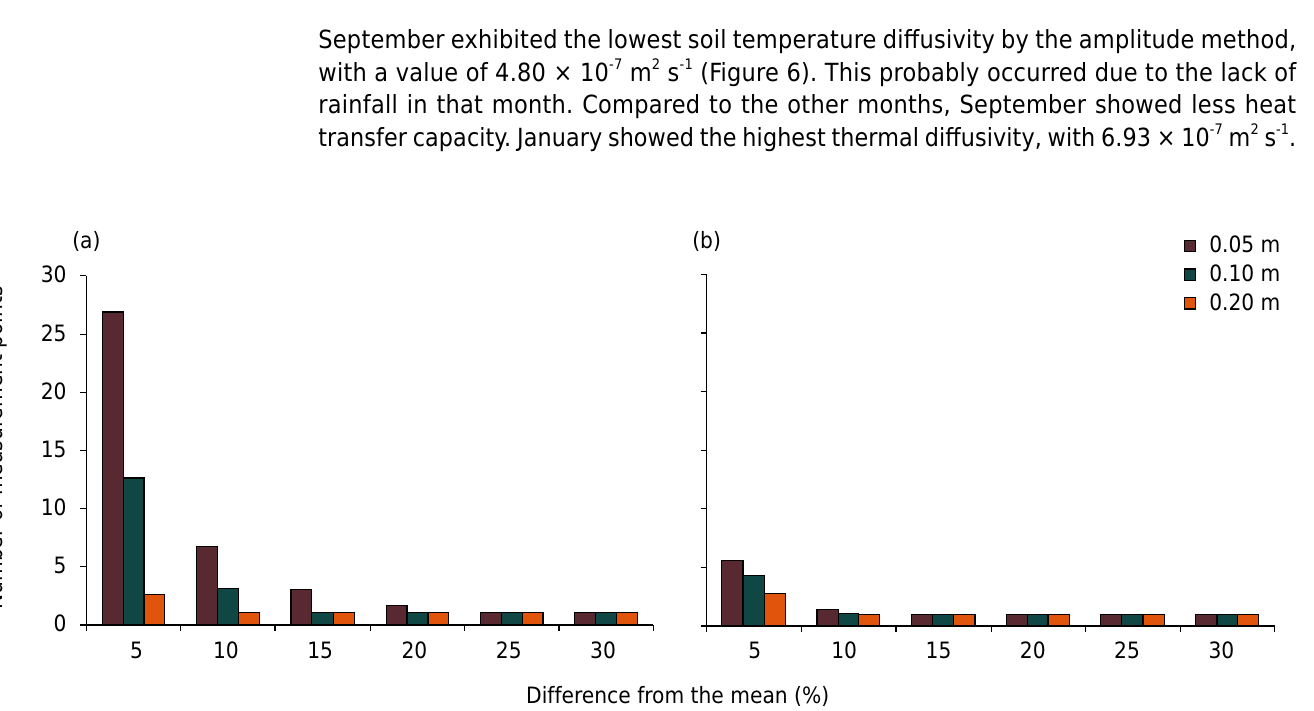
Figure 5. Minimum number of measurement points required to estimate the monthly hourly (5a) and daily (5b) soil temperature to several difference from the mean in percentage, considering daily data of soil temperature of a Cambissolo Háplico Ta Eutrófico (Cambisol; Inceptisol) in São Gabriel, Irecê Identity Territory, Bahia,